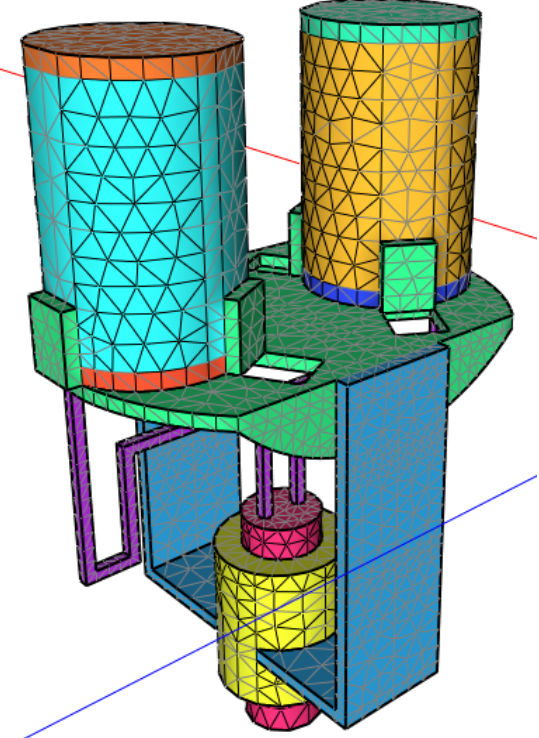
Figure 4. Computational mesh of the model-DSC sensor rod with reference and measurement crucibles.